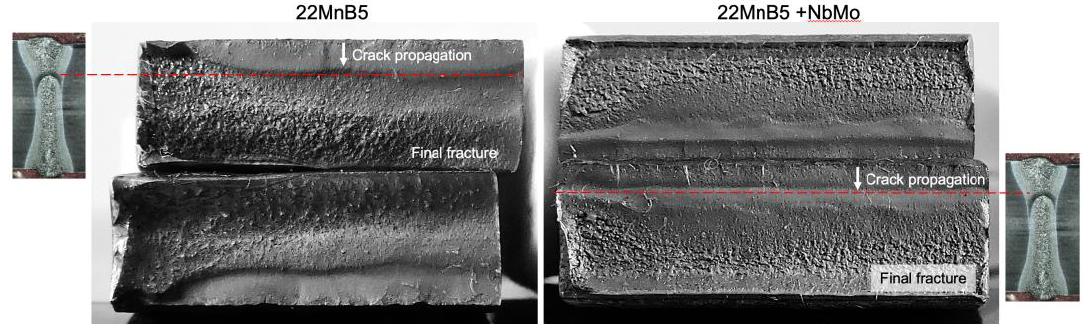
Figure 5. Mirrored fracture surfaces after fatigue failure. Standard 22MnB5 steel, tested at ∆ σ = 309.5 MPa [ σ max 344 MPa (0.24)S u-standard ] failure after 75,696 cycles. NbMo modified 22MnB5 steel, tested at = 307 MPa [ max 341 MPa (0.23)S u-modified ] failure after 216,578 cycles. Representative cross-sectional micrograph of the double-pass laser weld indicates the position of the weld overlap region (red dashed line).